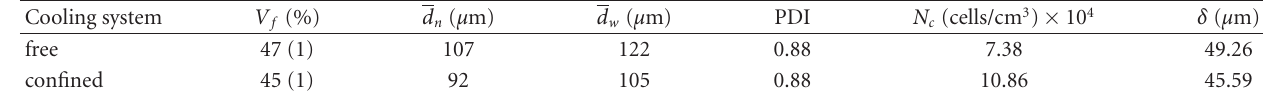
Table 12: E ff ect of the cooling system on the void content and the cellular structure (PLA 7000D, 2 wt% CBA1, temperature profile A,